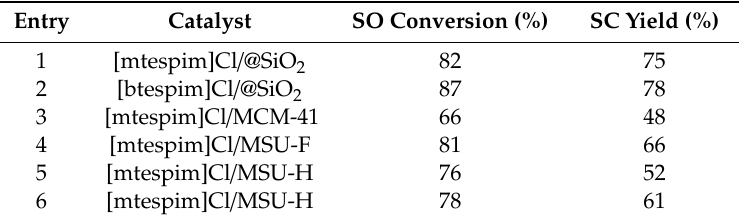
Table 4. Reaction of CO 2 with SO using various catalysts. Reaction conditions: SO, 0.13 mol;